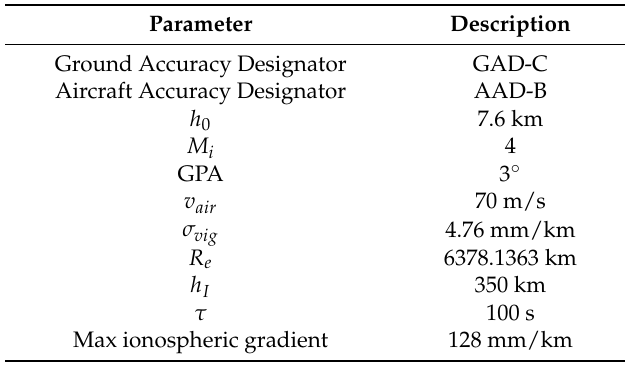
Table 2. Parameters used in the